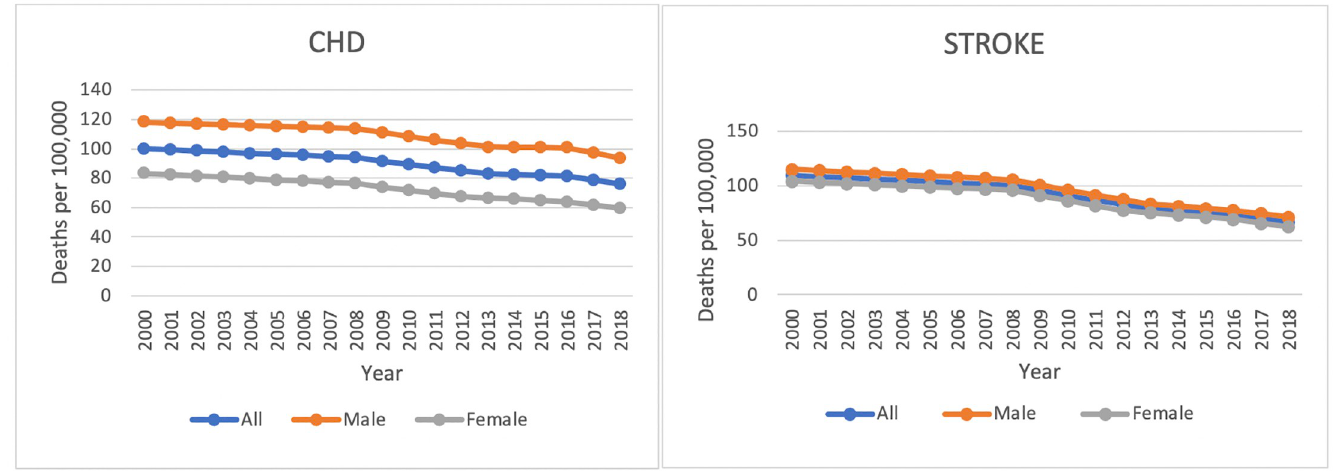
Fig 1. Trends in age-standardized mortality rates per 100,000 by sex for coronary heart disease and stroke. Brazil. 2000–2018.